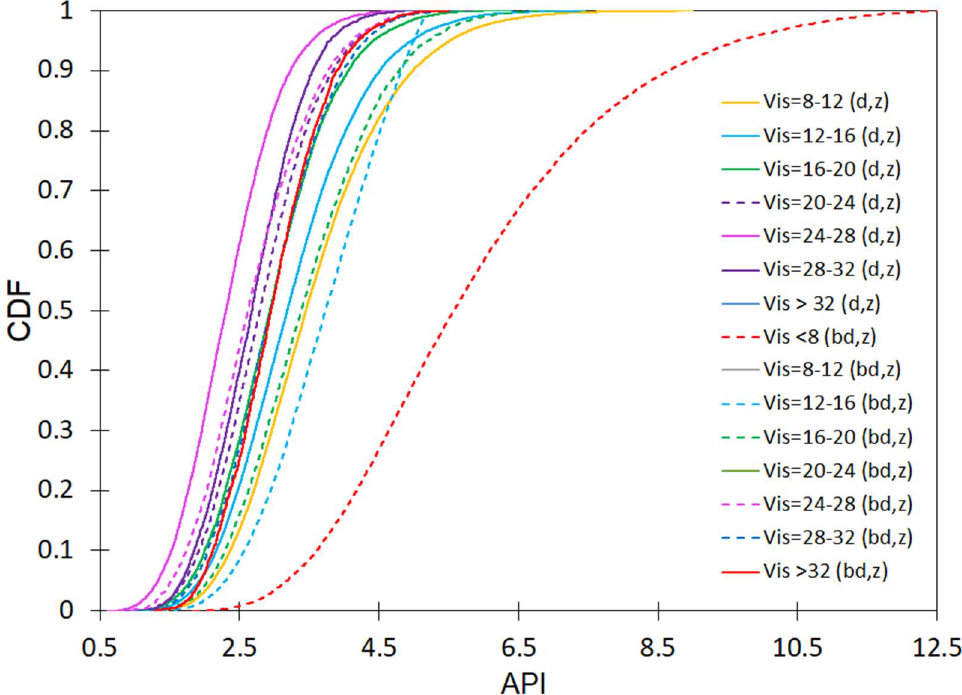
Figure A6. Effect of winter visibility on Air Pollution Index (API).